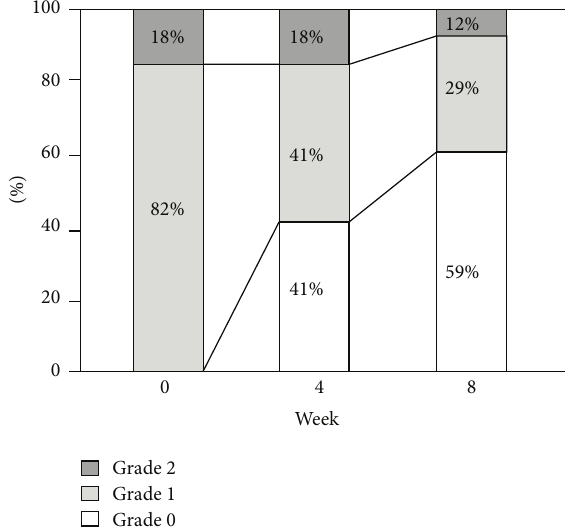
Figure 2: Evaluation of pain using pain grades at 0, 4, and 8